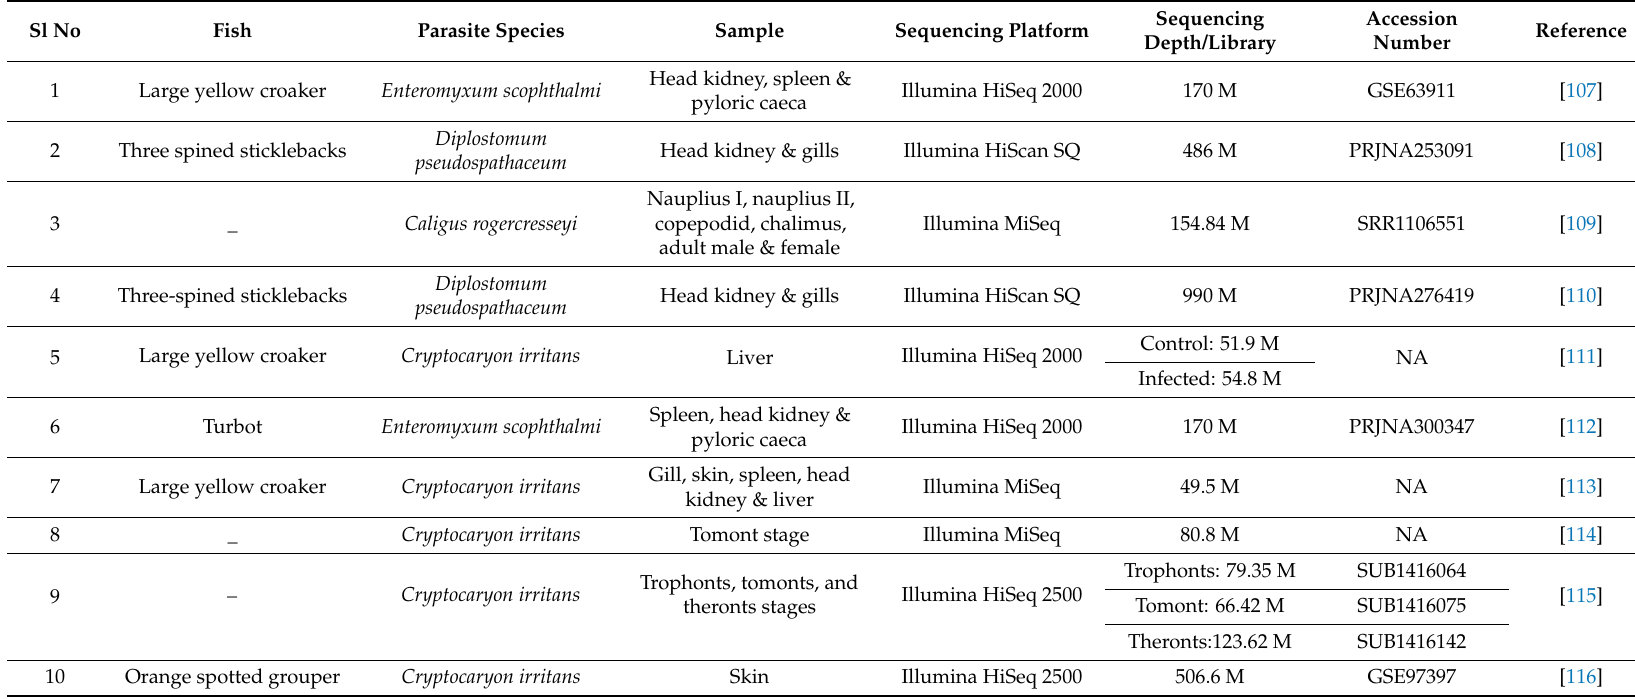
Table 3. RNA-Seq analysis of fish in response to parasites. This table shows a summary of investigations based on transcriptome analyses to understand parasitic diseases in various fish